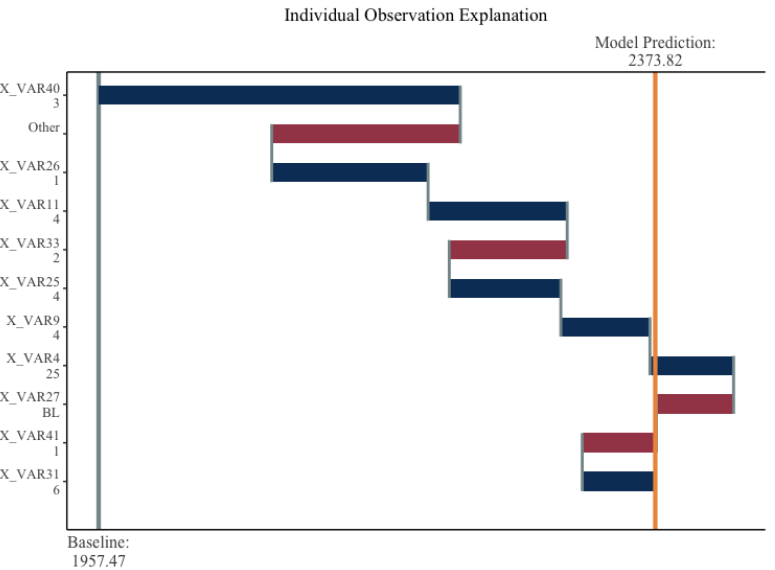
Figure 7. Observation plot from the two-part model’s mSHAP values. This plot shows how mSHAP can be used to explain a single